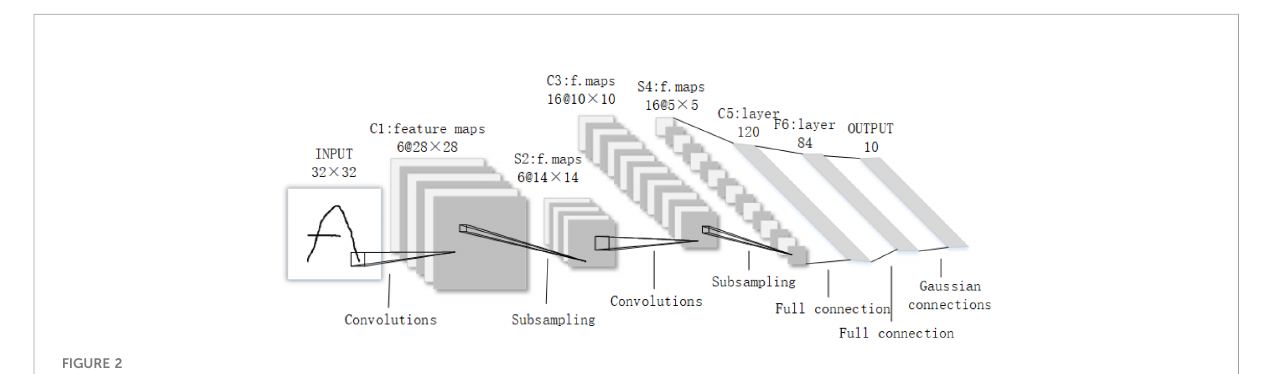
FIGURE 2 Schematic diagram of LeNet-5